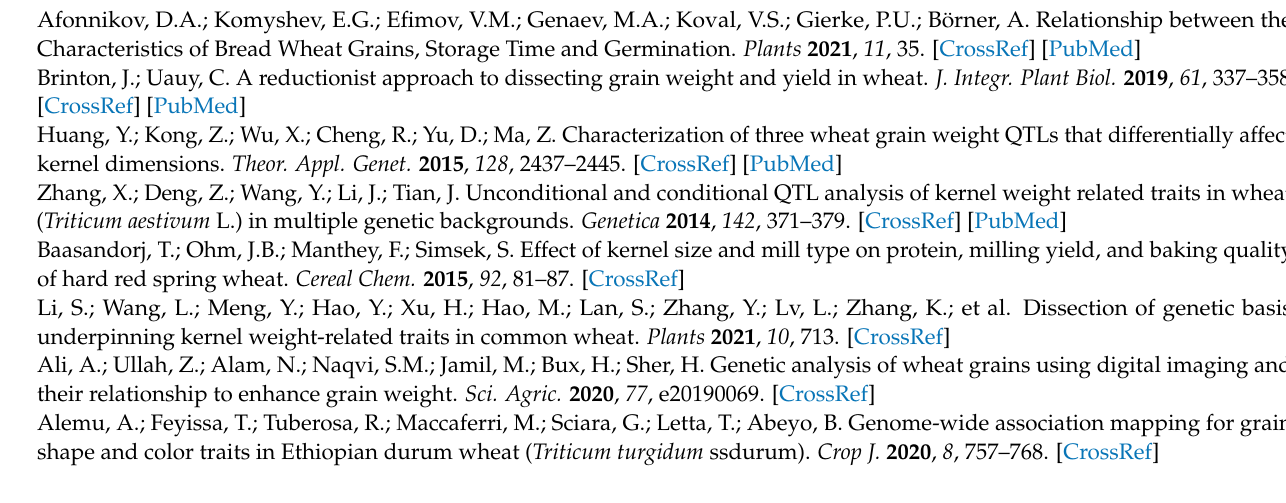
and 12 values for color components of four-color spaces); Figure S2: Examples of seed images used for digital phenotyping; Table S1: Complete list of QTLs identified through composite interval mapping. Left and right flanking markers linked to QTL are also provided along with LOD, PVE%, and additive effect (+ = provided by Opata and -= provided by W7984 parent). Similar asterisks (also highlighted in similar color) indicate likely identical loci. Markers highlighted in red are involved in multiple QTLs. Table S2: Pairs of epistatic quantitative trait loci detected in the ITMI/MP. Table S3: List of 197 (42 from rice and 155 from Arabidopsis) genes involved in molecular processes of the grain development. Input Gene ID = Gene ID from review papers; KEGG Gene ID = GID for gene in KEGG database; NA: not found in KEGG; KEGG Gene Name = Gene name in KEGG database and KEGG Orthology ID = Orthogroup ID in KEGG database. Table S4: Pathway ID and KEGG orthologous groups. Pathway KEGG = pathway ID and KEGG orthology group = Orthogroup ID in KEGG database. Table S5: List of QTLs used in gene prioritization. Table S6: List of 823 genes associated with grain